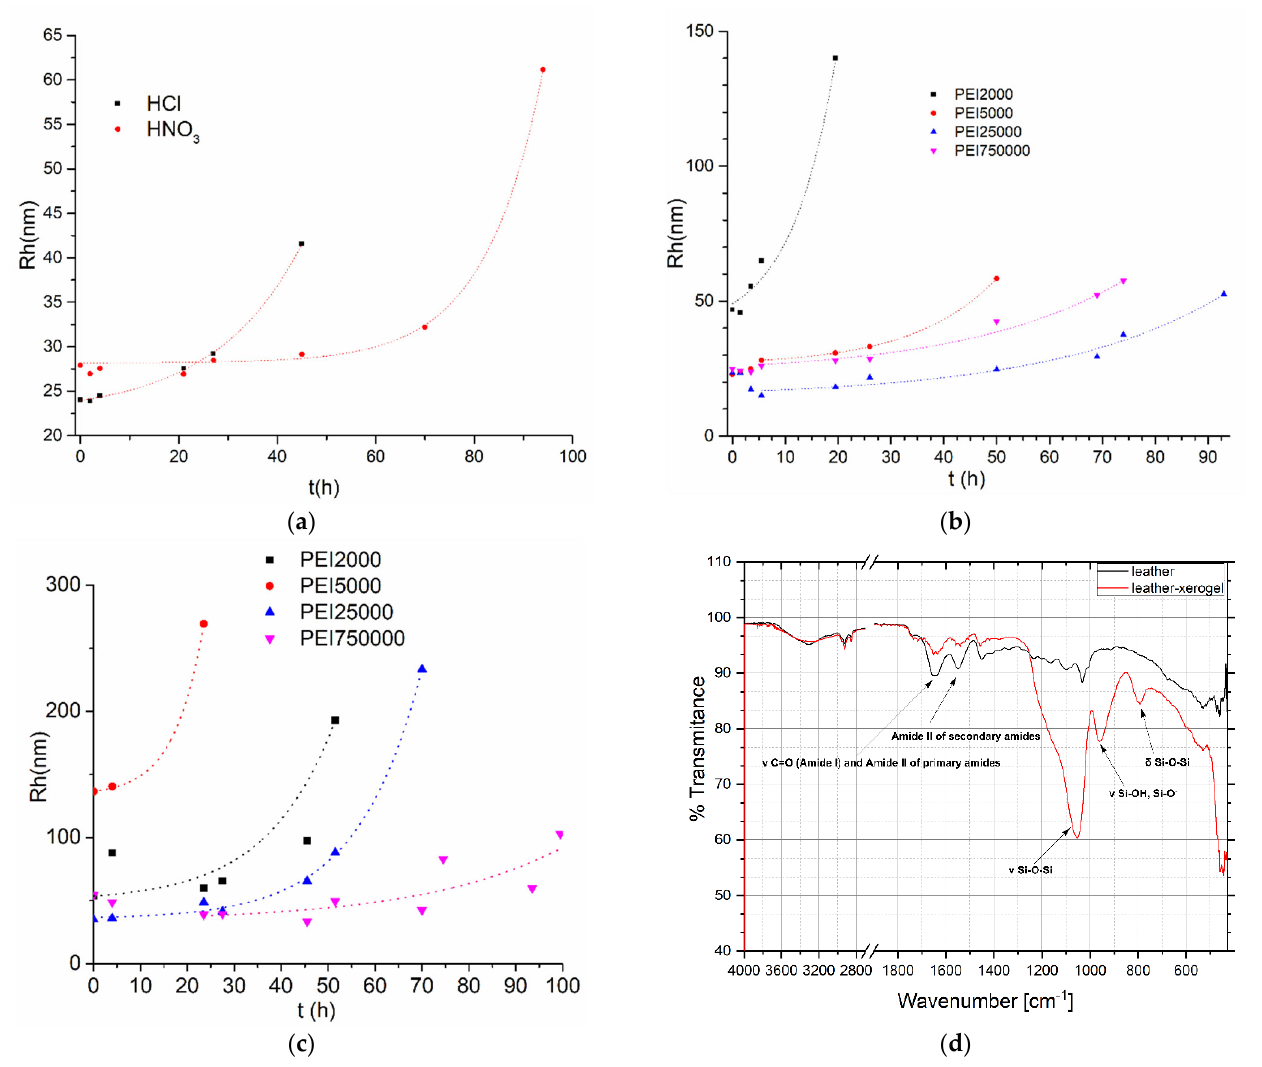
Figure 3. Size of agglomerates formed during the gelation process: ( a ) PEI 750,000 with tetra ethoxy silane hydrolyzed by HCl or HNO 3 , ( b ) Si(OH) 4 ‐ PEI, and ( c ) Ag Nps ‐ Si(OH) 4 ‐ PEI ‐ solutions as a function of time. ( d ) IR spectra of uncoated leather (black) and a sample coated with silica ‐ PEI 25,000 ‐ Ag Nps xerogel (red), exhibiting the characteristic collagen and silica bands ( ν stretching, δ bending). Table 1. Assignment of the IR absorption bands of the uncoated leather; leather treated by silica ‐